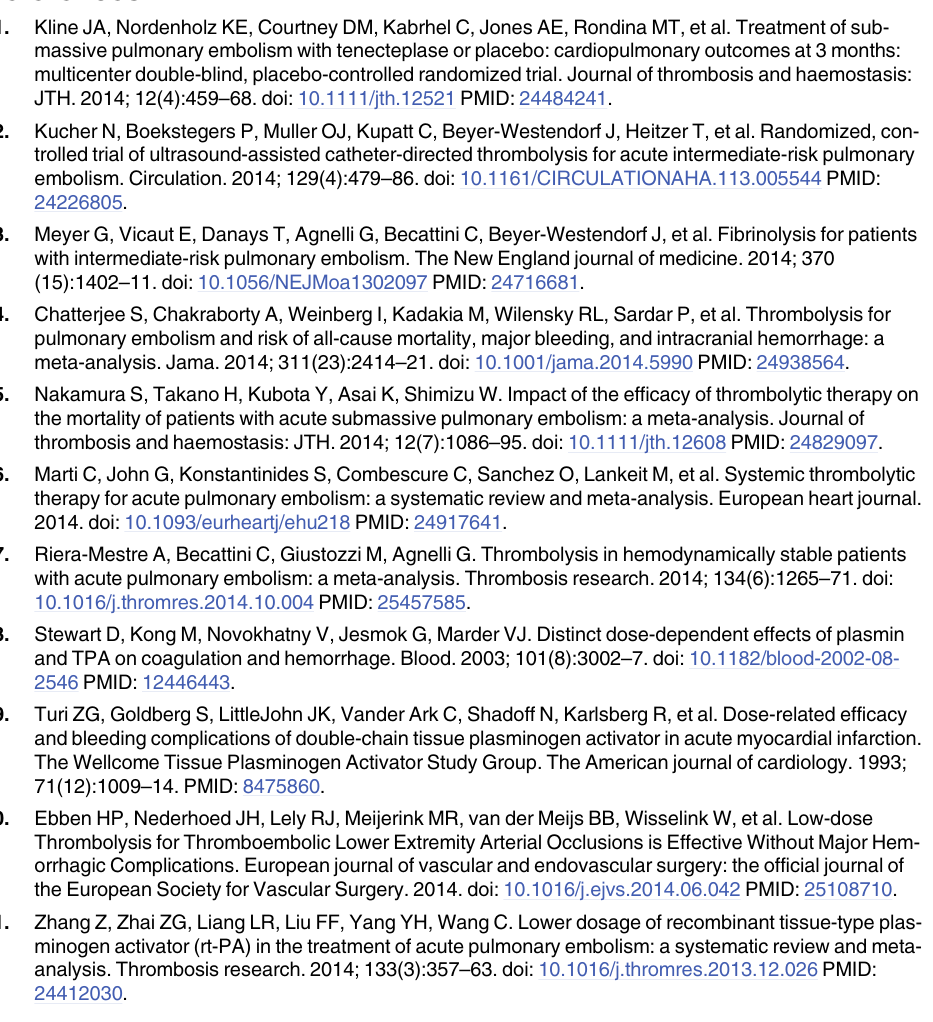
S1 Fig. A-D. Measurement of clot lysis time (CLT) using turbidimetry (A) and TEG (B). Char- acteristic curves demonstrating normal (solid line), and resistance to fibrinolysis (dotted line) using turbidimetry (C) and TEG (D). S2 Fig. Comparison of two methods of assessing resistance to fibrinolysis initiated by recombinant tissue plasminogen activator. (A) First order regression and (B) The Bland Alt- man plot (95% limits of agreement -1606 to +1921